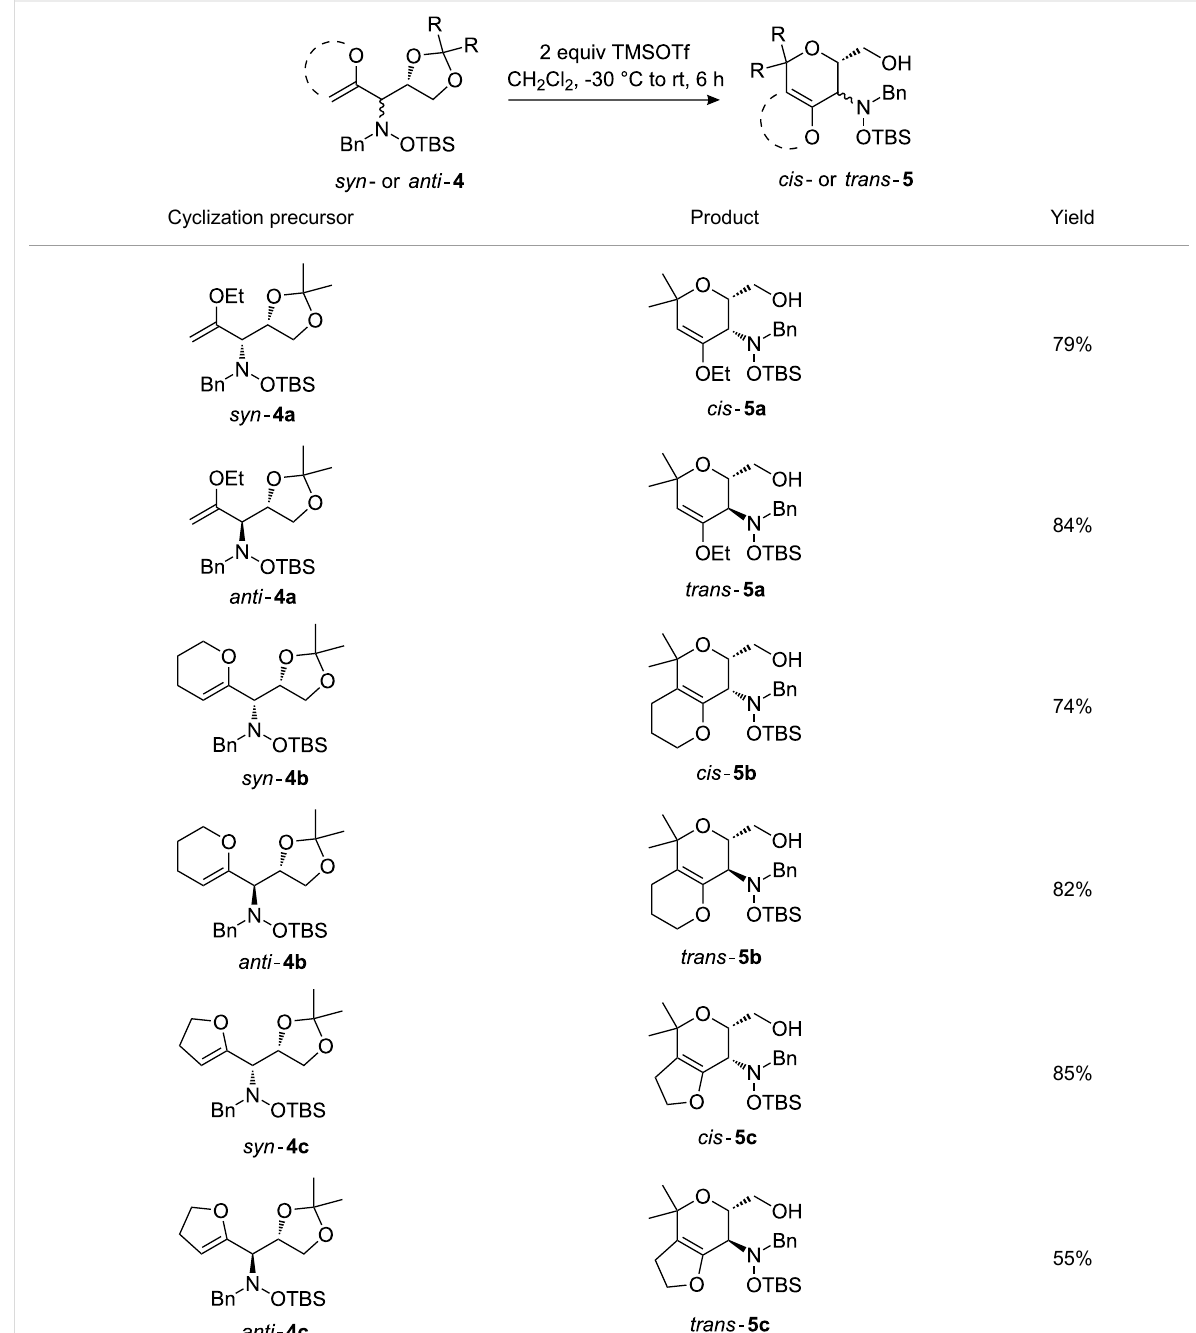
Table 2: Lewis acid promoted cyclization of 1,3-dioxolanyl-substituted enol ethers syn - and anti - 4 to 3,6-dihydro- 2H -pyrans cis - and trans - 5